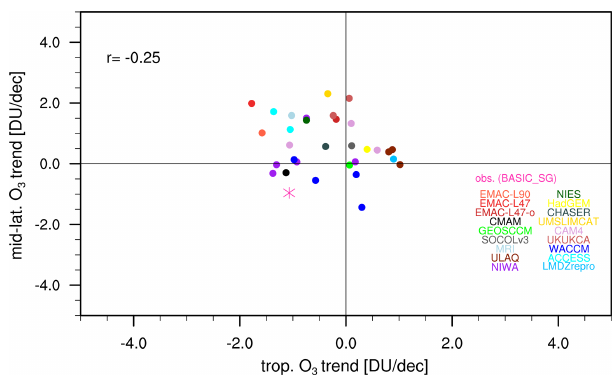
Figure 3. Inter-model correlation between tropical (20 ◦ S–20 ◦ N) and northern mid-latitude (30–50 ◦ N) LS ozone column trends, cal- culated over the period 1998–2018 for 31 CCMI REF-C2 simula- tions. All ensemble members of a particular model are shown in the same colour. The observational ozone trends (BASIC SG ) are in- cluded as a